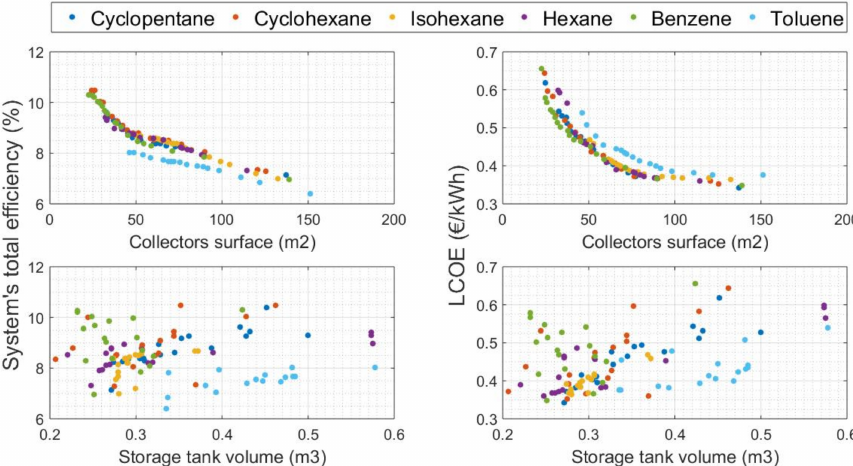
Figure 6. Variation of the optimization objectives (LCoE and η tot ) as a function of the optimization variables (A col and V st ) for a PTC-driven system in Athens for the investigated working